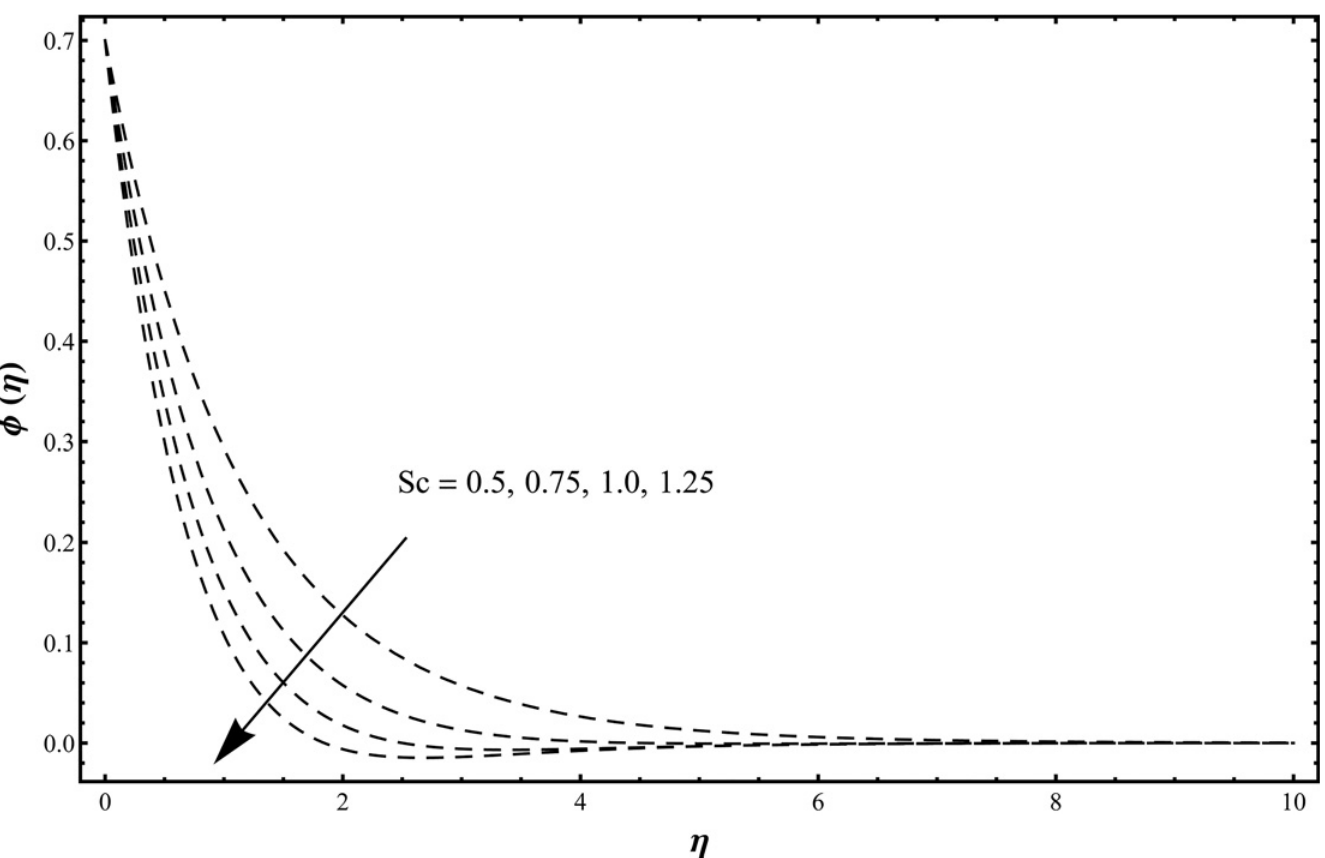
Fig 8. Concentration distribution function ϕ ( η ) when Sc = 0.5, 0.75, 1.0, 1.25 and β 1 = β 2 = 0.2 = γ = Rd , λ = 0.1 = N , Pr = 1.0, ε 1 = 0.3 = ε 2